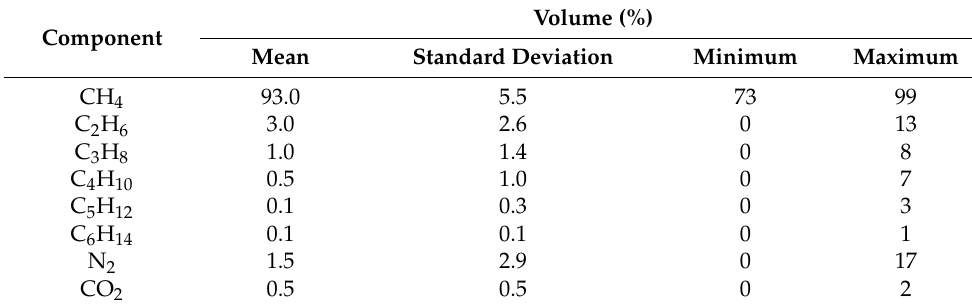
Table 6. Variation in composition of natural gas in the U.S.